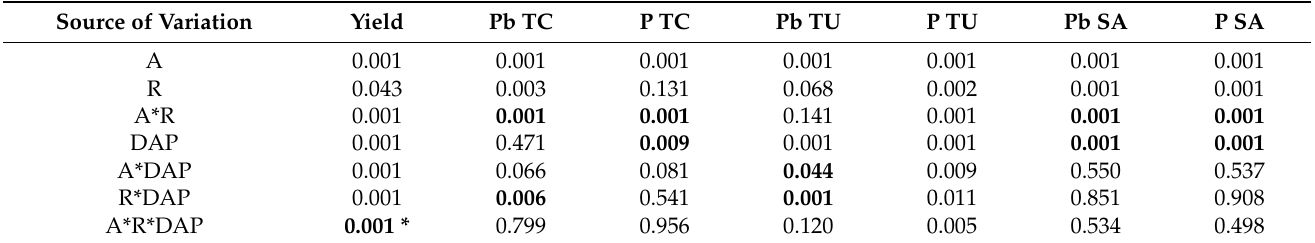
Table 4. ANOVA p -values that show the significance of the main and interaction effects of Amend- ment (A), Application Rate (R), and Diammonium phosphate (DAP) on Dry yield (Yield), and tissue concentration (TC), tissue uptake (TU), and soil available (SA) Pb and